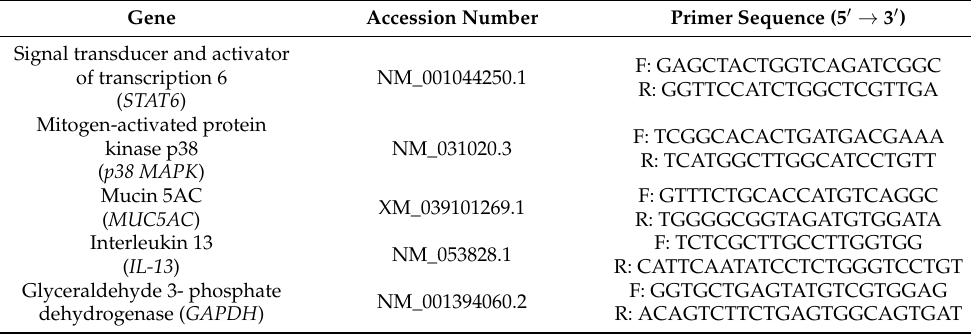
Table 1. PCR primers sequences and accession numbers of the studied